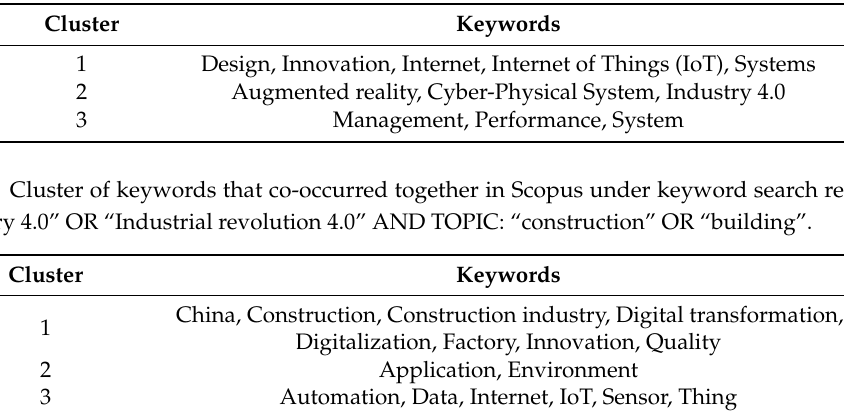
Table 3. Cluster of keywords that co-occurred together in Web of Science under keyword search related to “Industry 4.0” OR “Industrial revolution 4.0” AND TOPIC “construction” OR “building”.